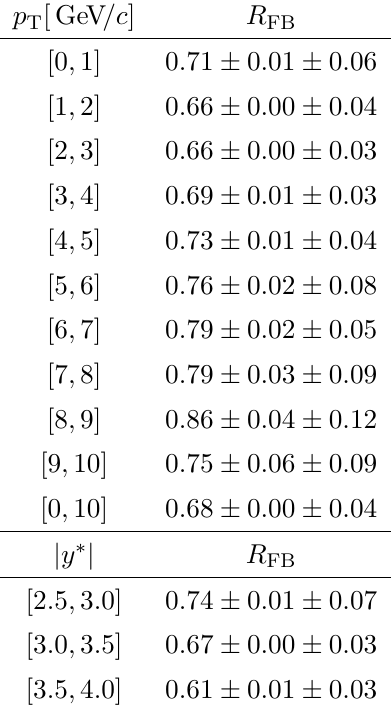
Table 7 . Forward-backward ratio R FB for prompt D 0 meson production in di(cid:11)erent p T ranges, integrated over the common rapidity range 2 : 5 < j y (cid:3) j < 4 : 0 for p T < 6 GeV =c and over 2 : 5 < j y (cid:3) j < 3 : 5 for 6 < p T < 10 GeV =c , and in di(cid:11)erent y (cid:3) ranges integrated up to p T = 10 GeV =c . The (cid:12)rst uncertainty is the statistical and the second is the systematic